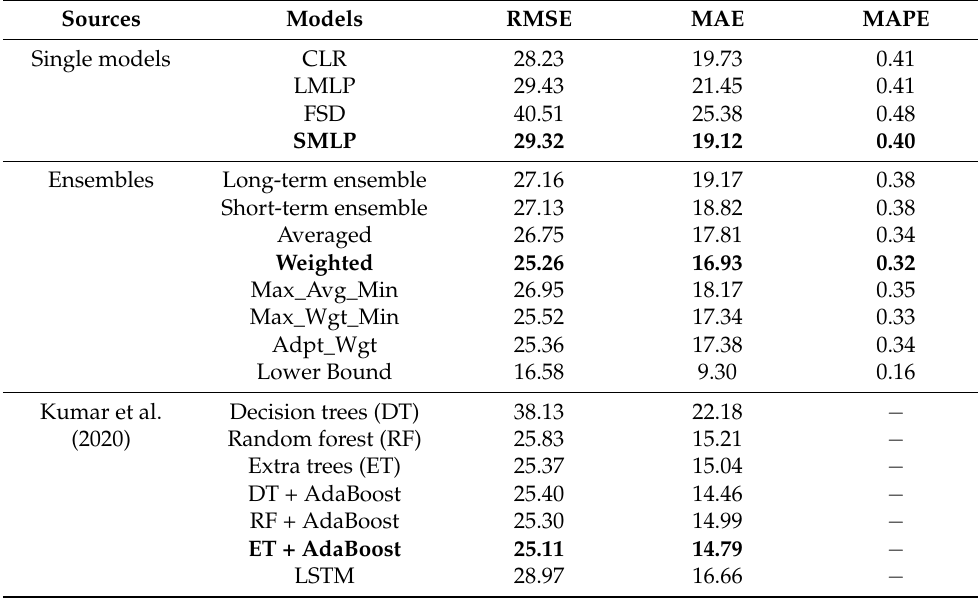
Table 8. Comparative performances of various methods on Delhi